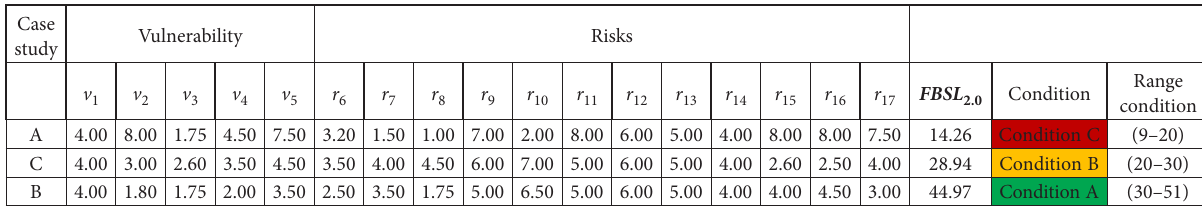
Figure 7. Pictures of the three case studies under analysis: a – Weiss shoe store; b – Heller house; c – Gómez brothers’ house Table 4. Input variables’ valuation during the in-situ visual inspection stage and final output of the fuzzy model (functional service life